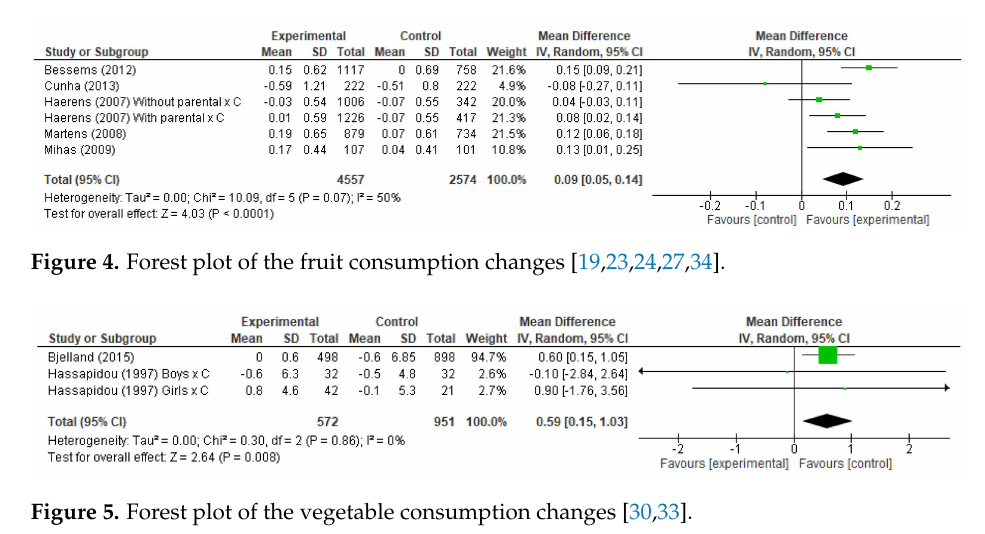
Figure 3. Forest plot of the fruit and vegetable consumption changes [17,32,38].